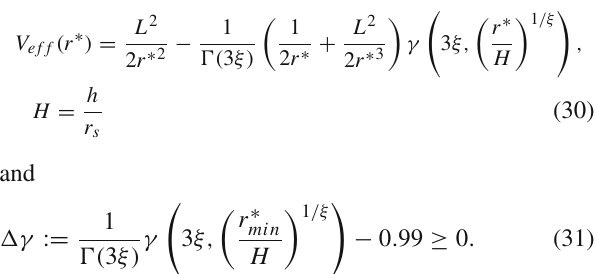
Fig. 5 Plot of the effective potentials (28) (asterisk symbol) (Schwarzschild case) and (30) (solid line) (fuzzy droplet) in the mas- sive case for L = 3, H = 10 and ξ = 0 . 2. The free parameter H is chosen so that it produces a scaling factor h of the same order as the one predicted by [29,30], i.e. h E = 2 . 121 × 10 − 9 kpc. The minimum of √ = 9 + 3 ) = − 0 . 01477 V ef f , S is at r ∗ 6 ≈ 16 . 35 where V ef f , S ( r ∗ min min ) = − 0 . 01477. Both potentials share the same minimum and V ef f ( r ∗ min and V ef f is a good approximation of V ef f , S in a neighbourhood of r ∗ min and asymptotically